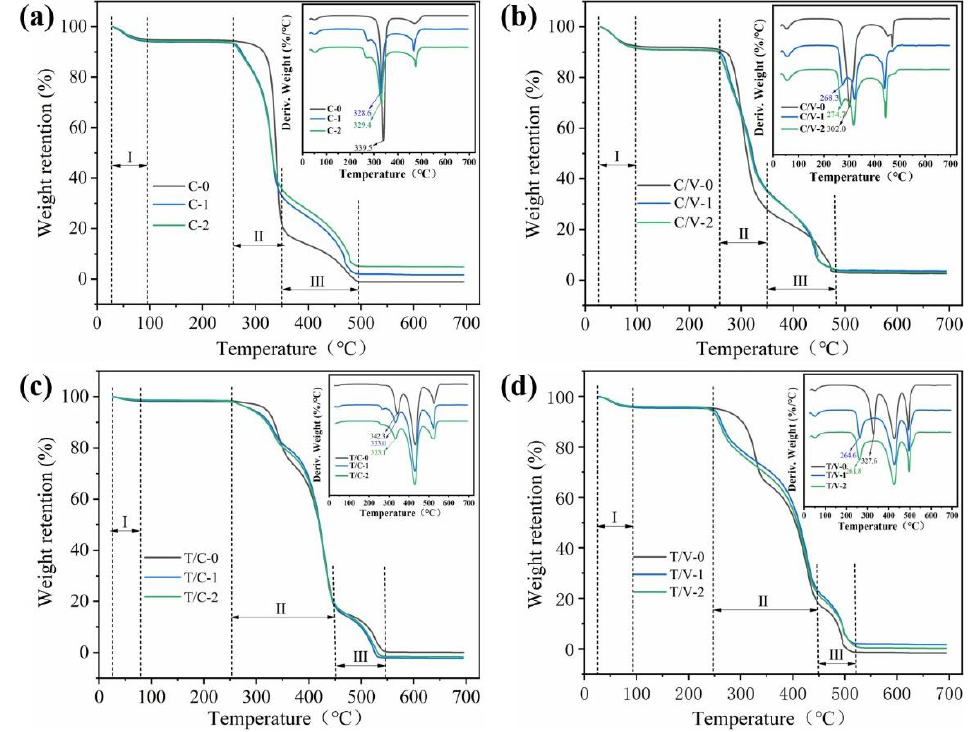
Figure 13. TG and DTG of original and treated cotton fabrics. ( a ) cotton; ( b ) cotton/viscose; ( c ) polyester/cotton; ( d ) polyester/viscose.